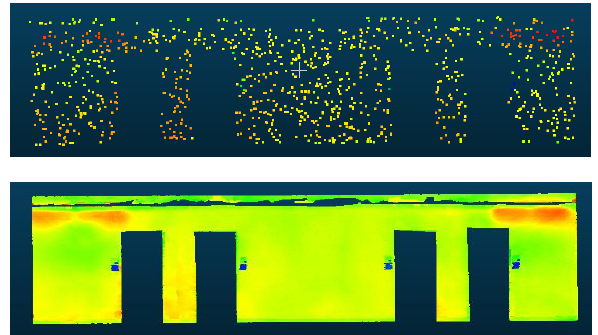
Figure 3. Representation of a wall in a small scale and large scale by controlling number of points to render after the cLoD sorting.